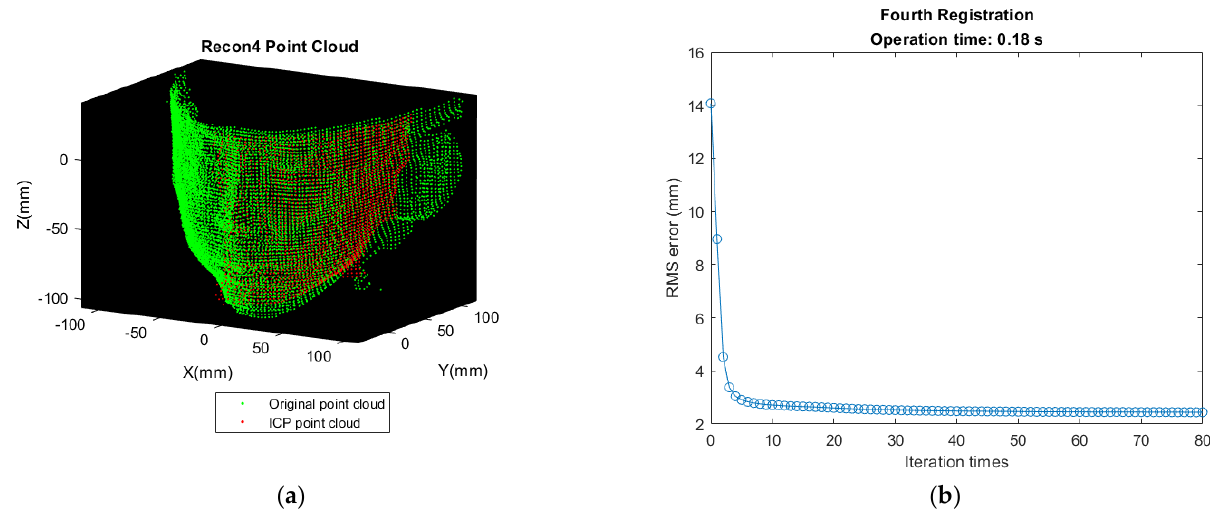
Figure 15. Result of fourth registration and deviation. ( a ) Recon 4 Cloud shows that partial features at right face have been reinforced. ( b ) The RMS error becomes small because of denser Recon 3 Cloud.